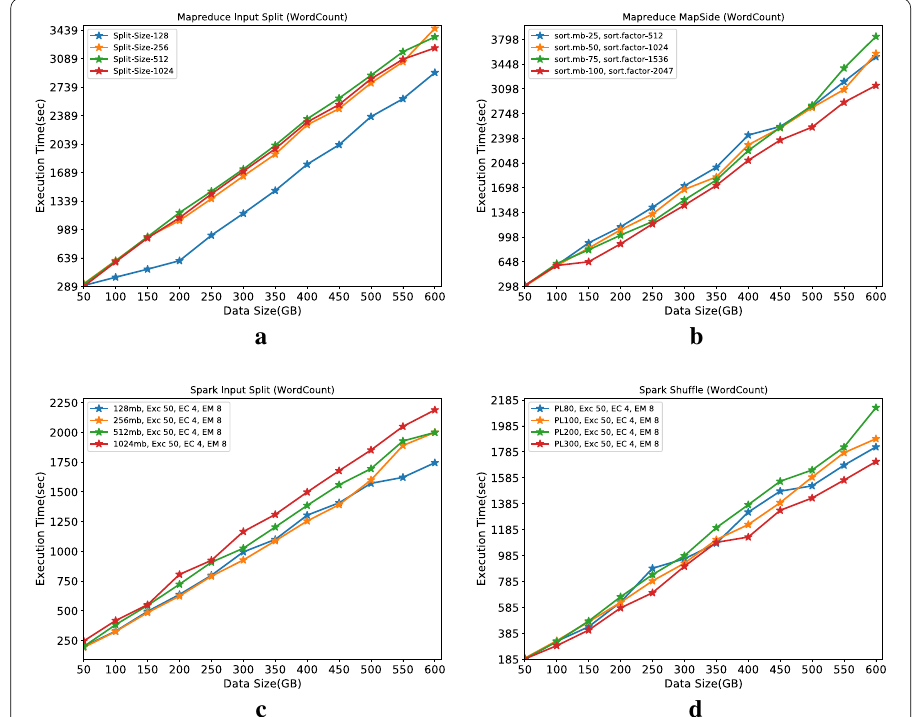
Fig. 4 The performance of the WordCount application with a varied number of input splits and shuffle